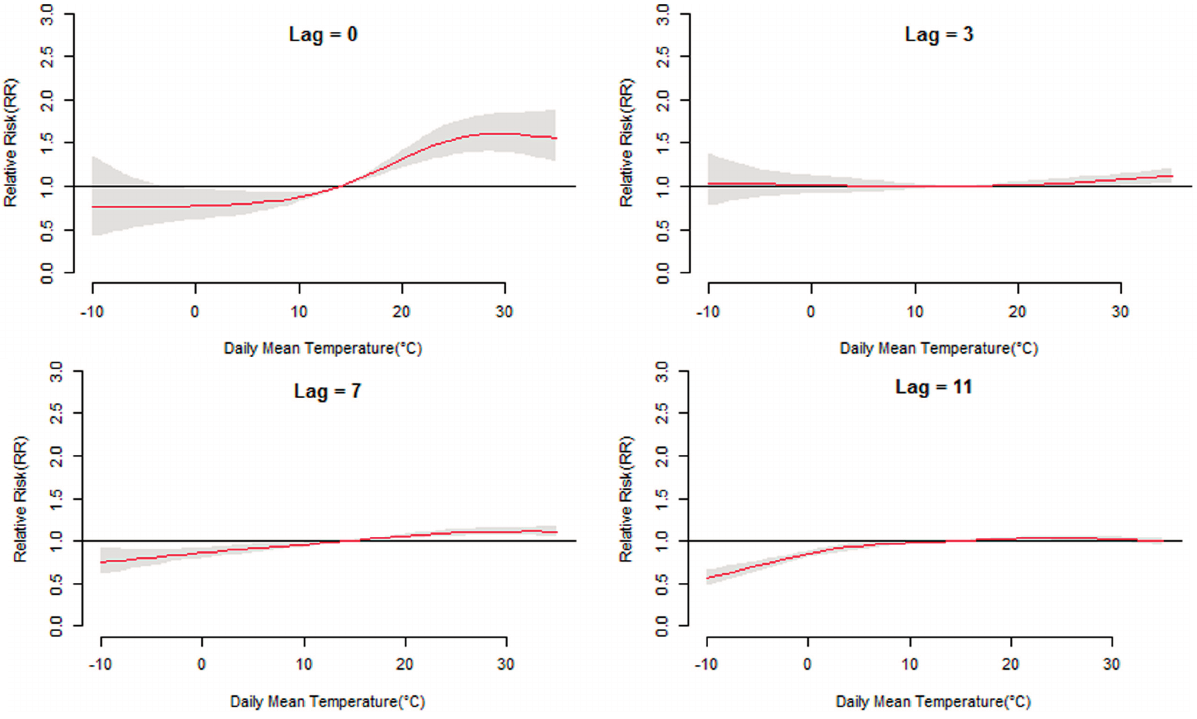
Figure 3. Relative risks of daily HFMD by daily mean temperature along 14 lag days in Jinan and Qingdao, adjusting for relative humidity, rainfall, sunshine duration, DOW, holidays, seasonal trend, and long trend: ( a ) Jinan, ( b )